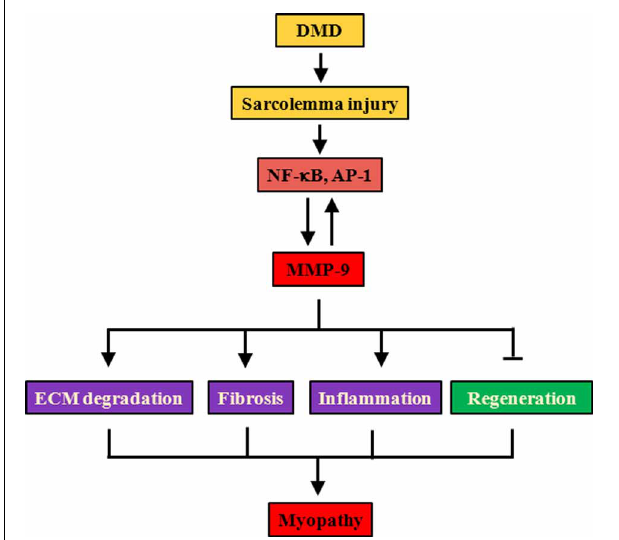
FIGURE 2 | Proposed mechanisms of action of MMP-9 in DMD. Lack of dystrophin leads to destabilization of DGC, increased susceptibility to contraction-induced injury, and finally degeneration/regeneration of myofibers. Cycles of fiber degeneration and regeneration augment inflammatory response with concomitant activation of proinflammatory transcription factors NF- κ B and AP-1. NF- κ B, and AP-1 augments the gene expression of MMP-9. Increased production of MMP-9 also induces NF- κ B and AP-1 activity potentially through proteolytic activation of various latent cytokines. Persistent presence of high levels of MMP-9 causes fiber necrosis, inflammation, and fibrosis and interferes with regeneration of damaged myofibers leading to myopathy. AP-1, activator protein 1; DGC, dystrophin-associated glycoprotein complex; DMD, Duchenne muscular dystrophy; MMP-9, matrix metalloproteinase-9; NF- κ B, nuclear factor-kappa